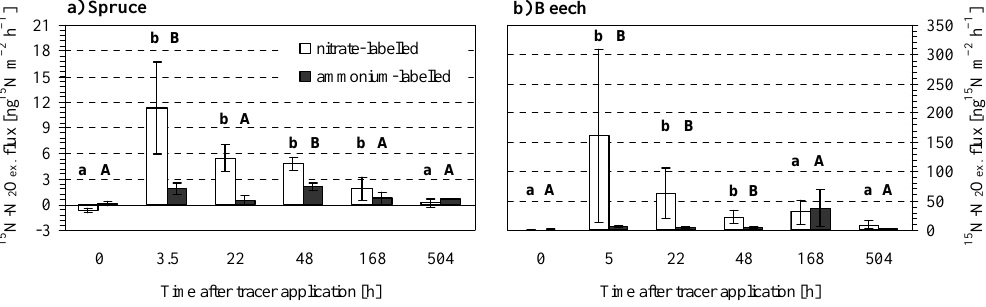
Fig. 2. Mean ( ± SE, n = 4) 15 N-N 2 O excess fluxes in the spruce stand (a) and beech stand (b) during the short-term experiment. Fluxes are given for the NO − -labelled and NH + -labelled treatments before (zero hours) and after the tracer application. Means followed by the same letter indicated no significant differences in 15 N-N 2 O excess fluxes of one labelling treatment (NO 3− - or NH 4+ -labelled) between zero hours and the time points after the tracer application (mixed effects models with linear contrasts at P ≤ 0.05). Please note the different scales.